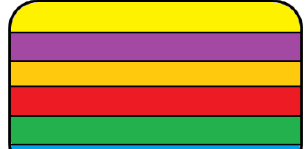
Figure 10. Cross-section of the cylinder-shaped polypill. Each color represents diverse API-containing layers: naproxen—yellow; aspirin—purple; paracetamol—orange; caffeine—red; chloramphenicol— green; and prednisolone—blue [57].